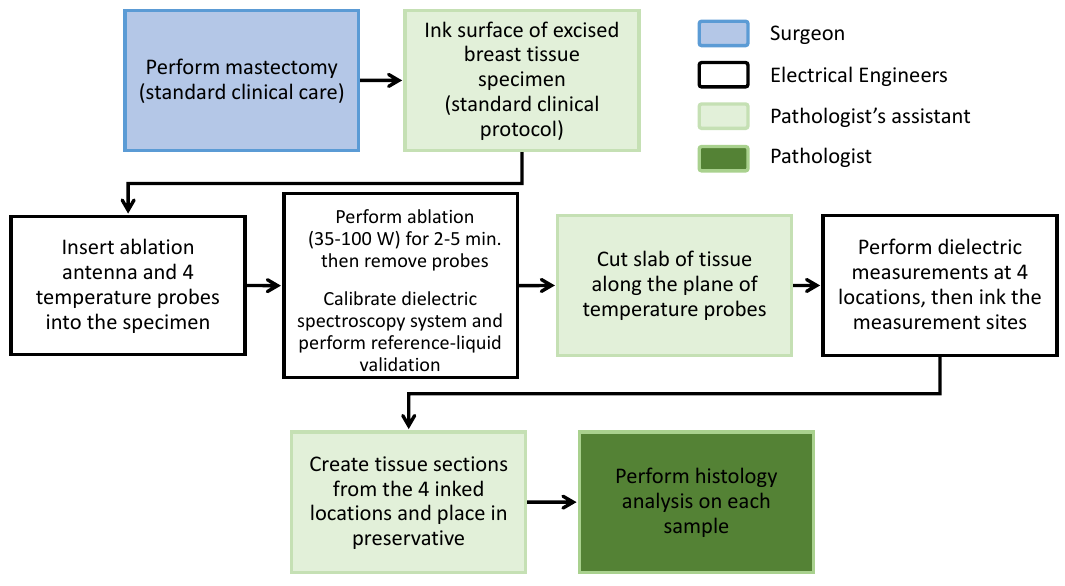
Figure 1. Steps of the experimental